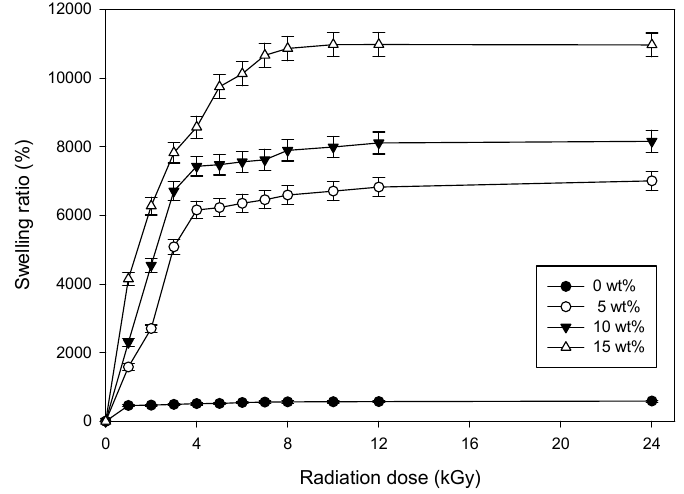
Figure 3. The water absorption ratio of CH–CMC hydrogels with different content of honey; radiation dose is 75 kGy.